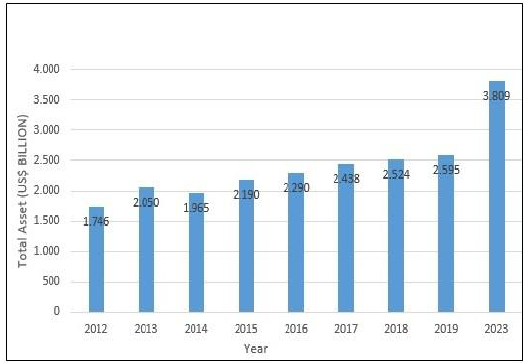
Figure 1. The 2023 Growth of Global Islamic Finance